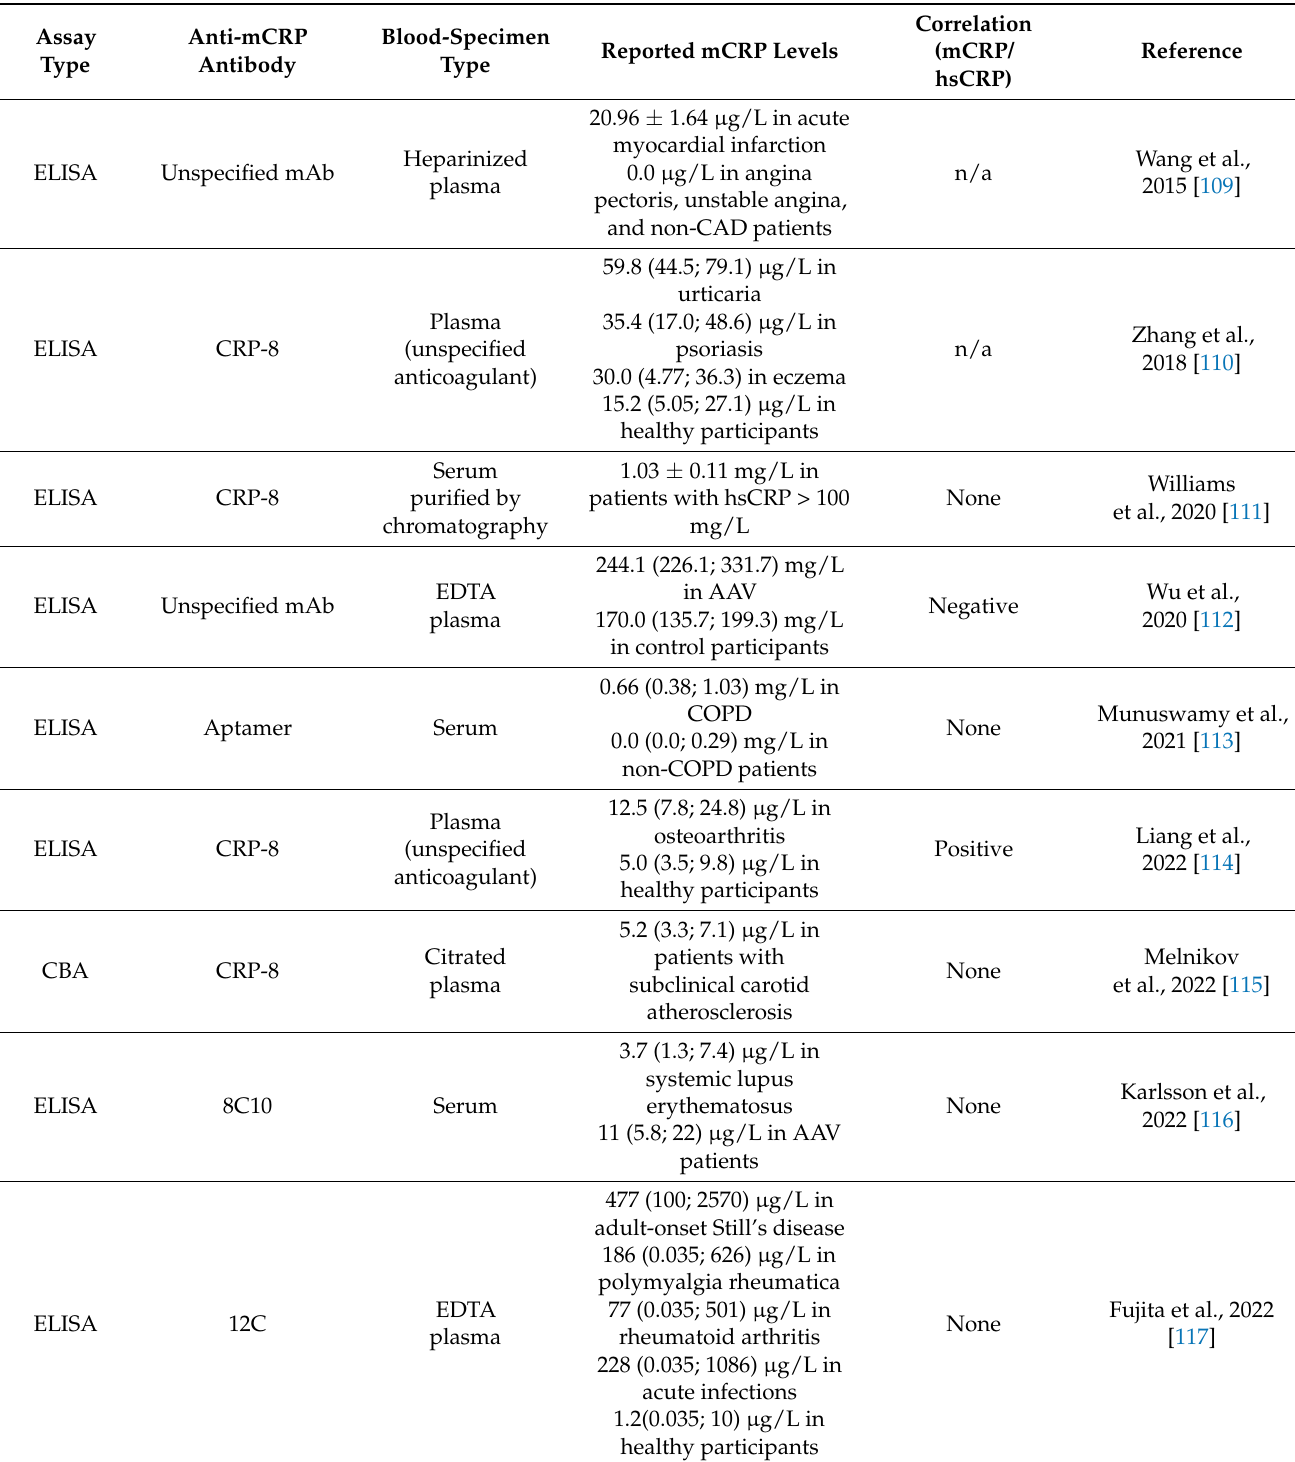
Table 1. Monomeric C-reactive protein